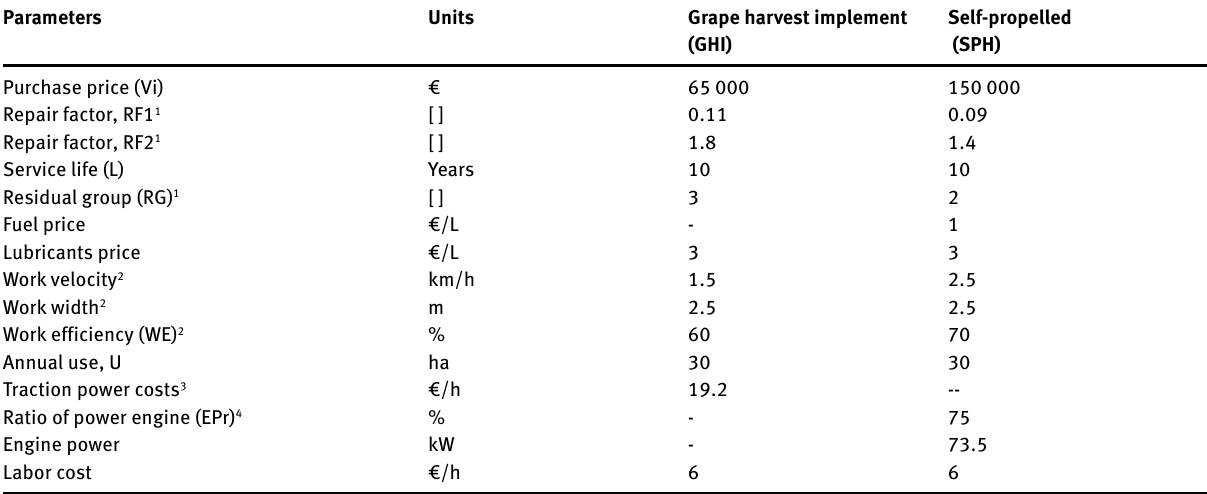
Table 4: Machinery data used for function cost estimation for each harvest machine tested in the case-study